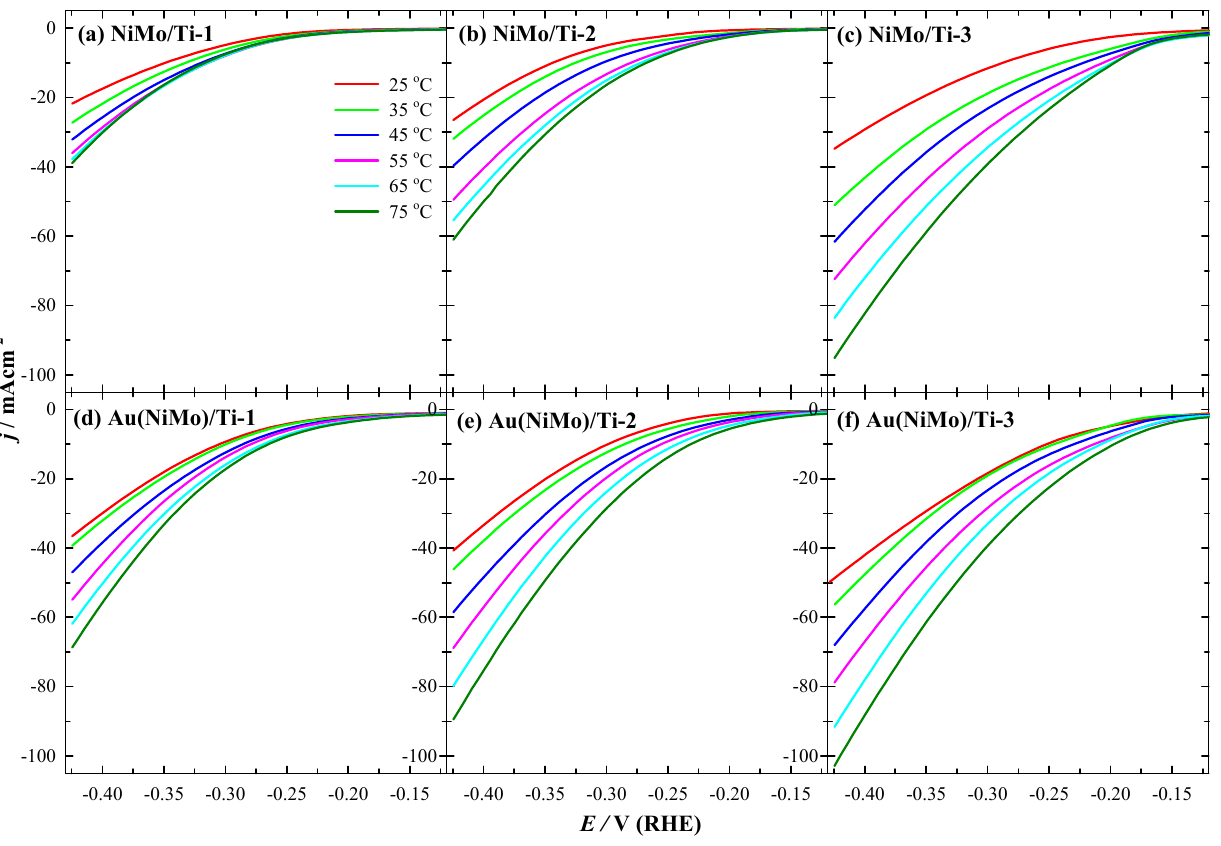
Figure 3 . HER polarization curves of 3D NiMo/Ti ( a – c ) and Au(NiMo)/Ti ( d – f ) catalysts in 1 M Table 3. Electrochemical performance of the tested catalysts toward HER in alkaline media. j (mA · cm − 2 ) in Different Temperatures ( ◦ C) at − 0.424 Catalysts